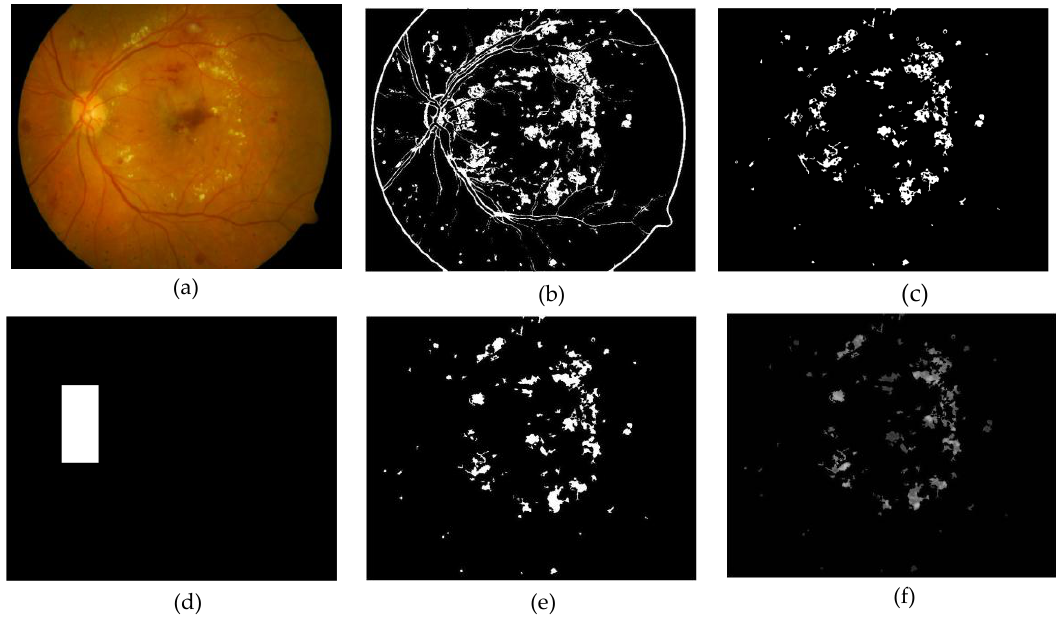
Figure 5. The processing steps of image segmentation: ( a ) Retinal image; ( b ) DR lesions detection; ( c ) blood vessels elimination; ( d ) rectangular mask ( e ) resulted image after post processing step and ( f ) segmented result in grayscale image. Table 1. Features extraction and its description.